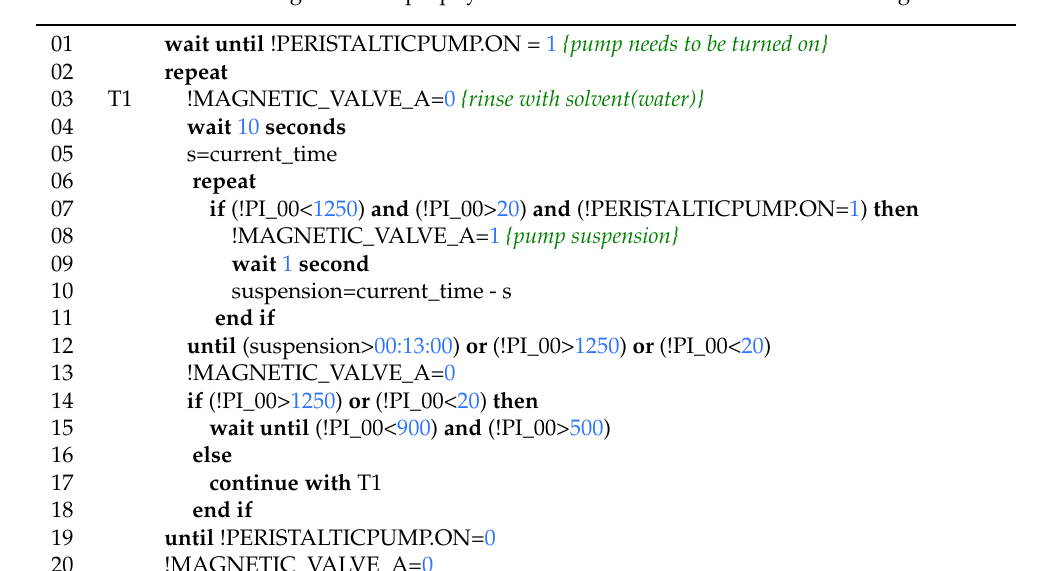
Table A4. HiText™ rinsing code for “prophylactic rinse” translated from German to English.